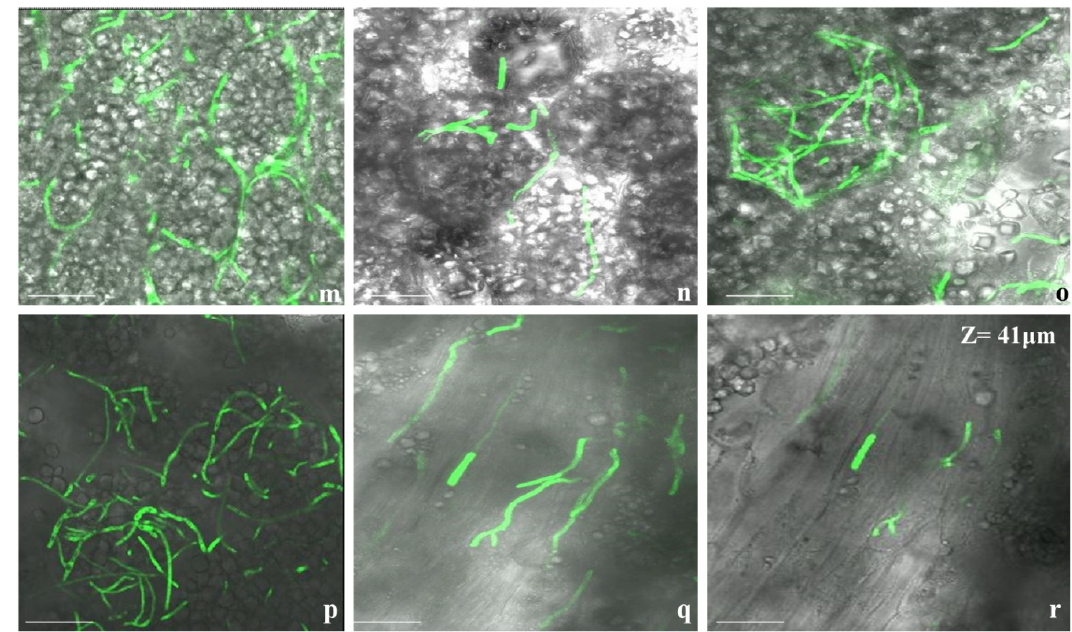
Figure 9. Different stages of colonization of tagged Fox R1 in infected corm tissue of saffron. ( a , b ); Corm tissue at 6 hpi, characteristics sickle shape spores clearly visible, ( c , d ); spore germination at 12 and 18 hpi, ( e ); 1 dpi, Y shape structure were seen (indicated by arrows), ( f – h ); hyphae continue to grow and covered the tissue surface, at 2 dpi it started penetrating inside the inner layers of the tissue, ( i , j ); septate hyphae clearly visible (indicated by arrows) at 5 dpi, ( k , l ); hyphae at 8 and 12 dpi few of the hyphae were seen inside the corm tissue, ( m , n ); represents the Fox R1 in the extracellular spaces of the corm tissue, ( o , p ); represents the Fox R1 inside the corm cell at 20 dpi and ( q , r ); represents the Fox R1 in the vascular tissue. ( a , r ); represents merged images after z- stacking using laser scanning confocal microscope. Each bar represents 10 µm.